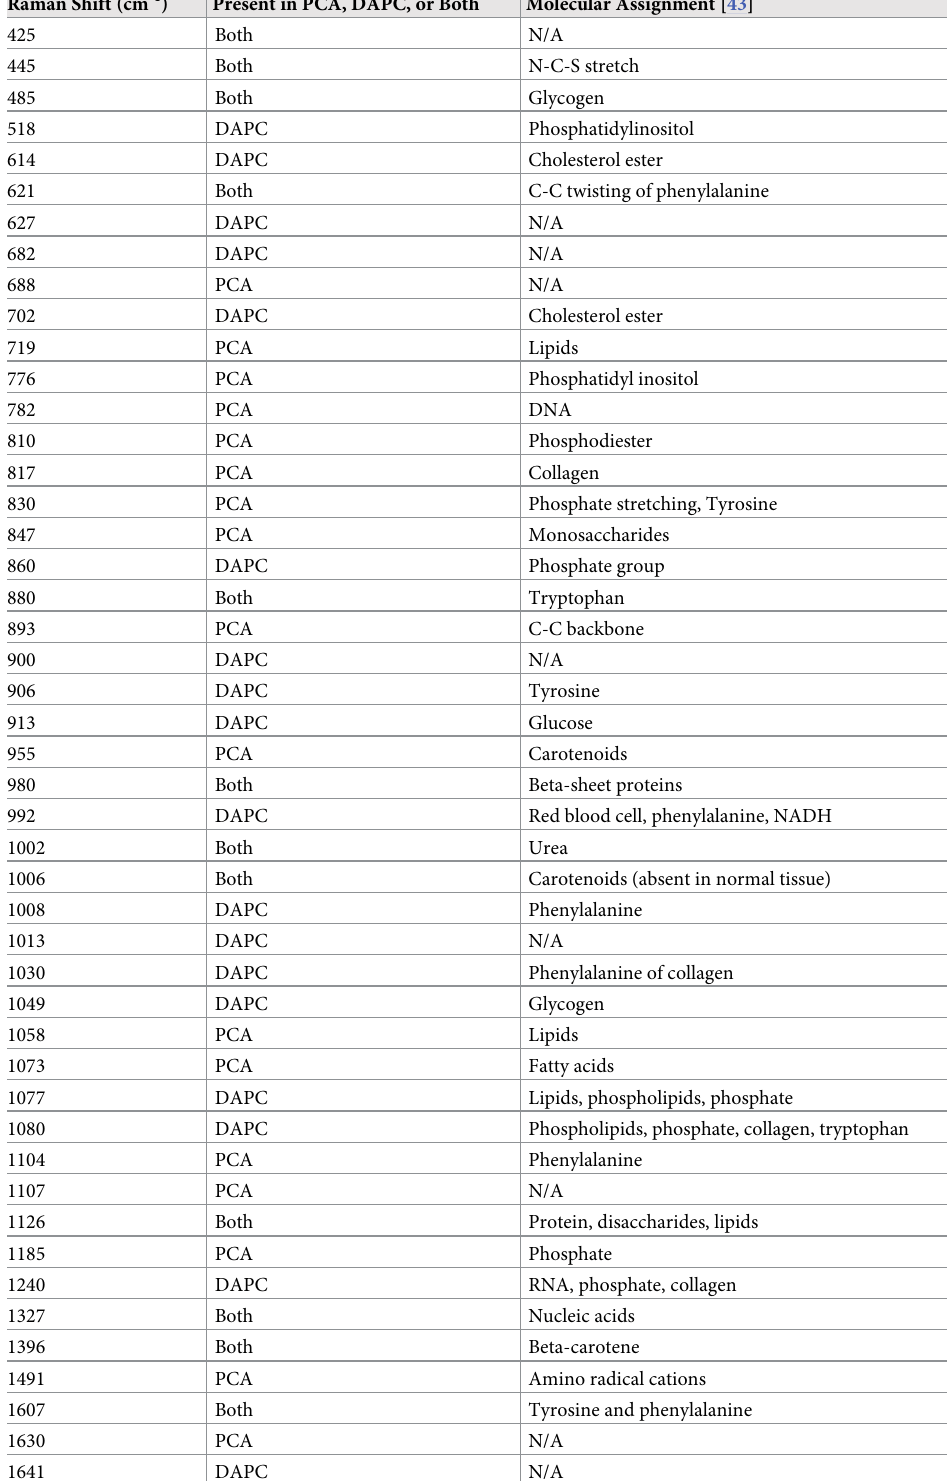
Table 3. Molecular assignments for Raman shifts leading to cluster separations in Fig